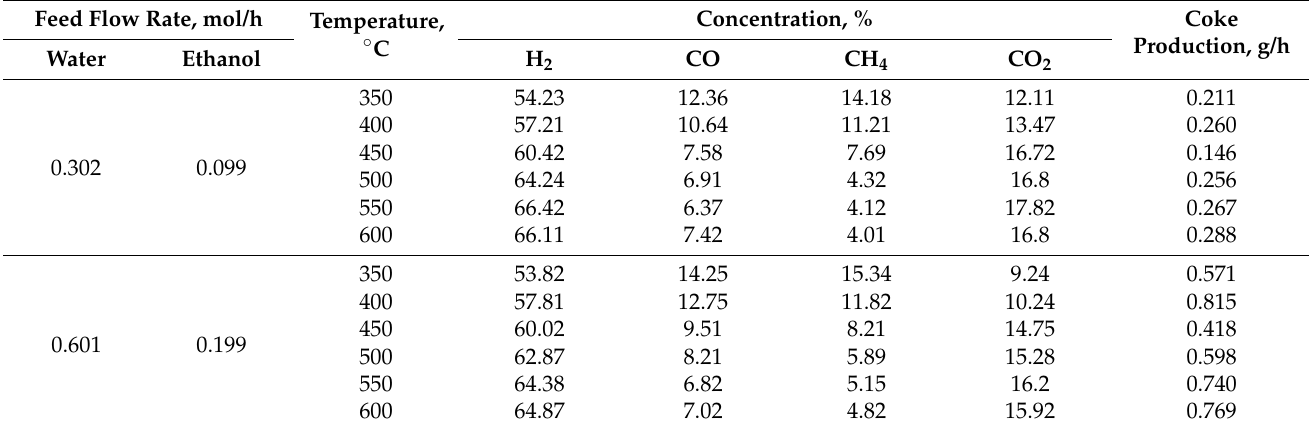
Table 1. The concentration of gaseous products in gases after cooling and coke